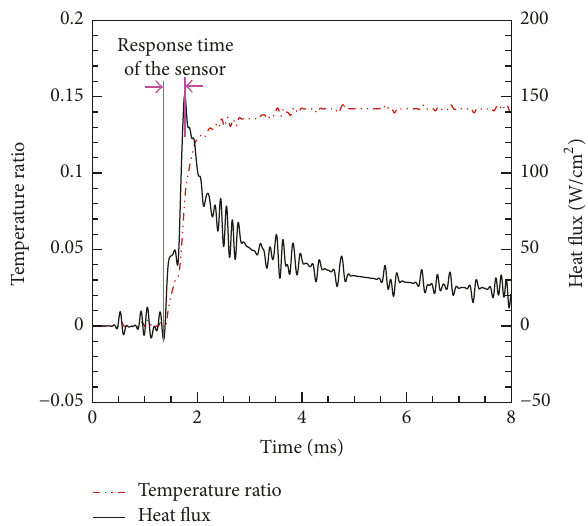
Figure 12: Temperature and corresponding heat flux signal for a water drop